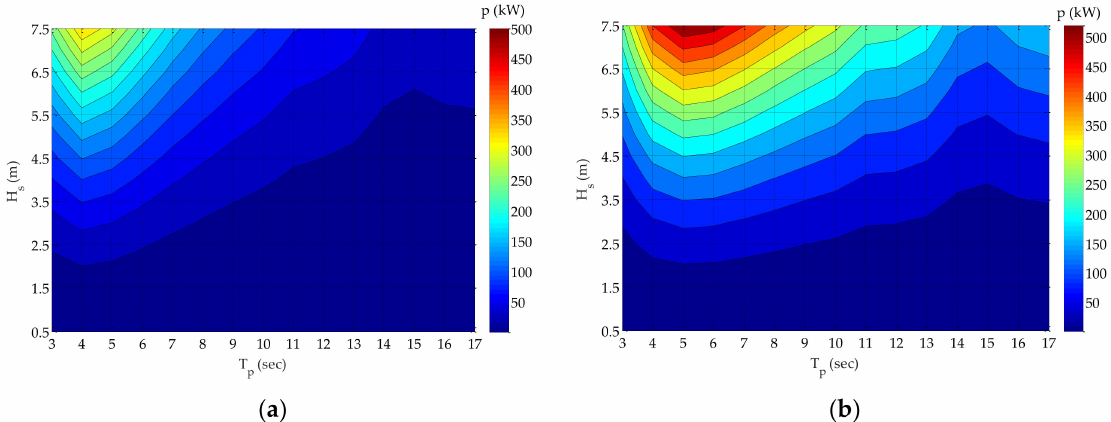
Figure 18. Comparisonof power absorbed by the array the oblate spheroidal WECs and d net = 0.125 r 0 under the action of irregular wave with β = 45 o by utilizing ( a ) a PTO with constant b PTO equal to B ISO with b PTO ( ω )